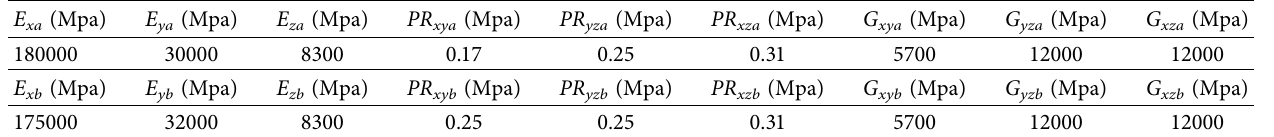
Table 1: Engineering elastic constants of orthotropic bimaterial.